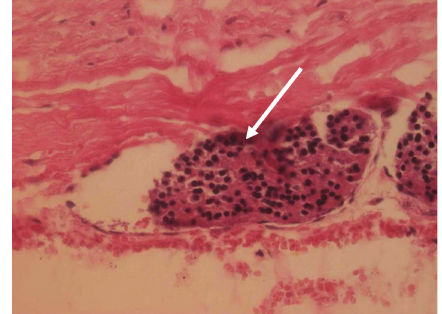
Figure 2: Histological findings of parathyroid carcinoma—vascular invasion (arrow); HE, ×